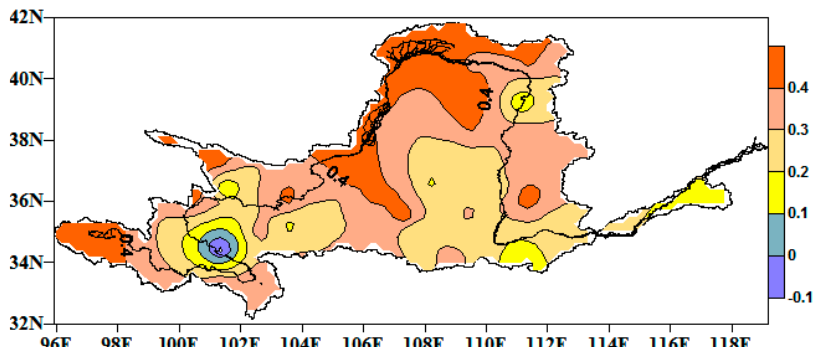
Figure 2. Spatial distribution of temperature change over the YRB (unit: °C decade − 1 ).